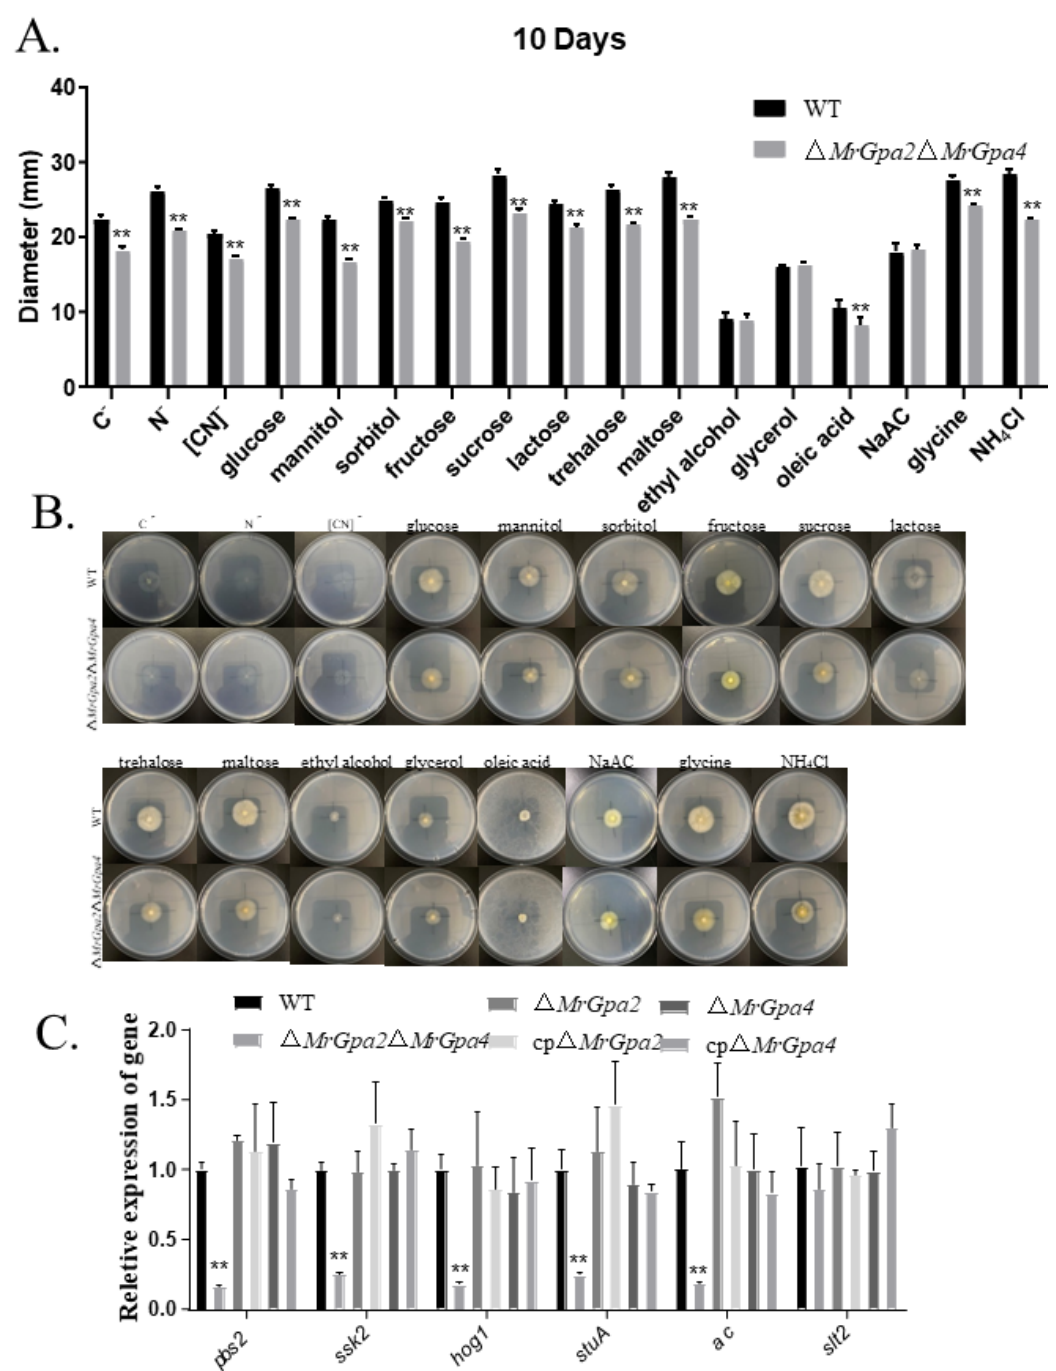
Figure 4. MrGpa2 and MrGpa4 affect hyphal growth in CZAs plates. ( A ) Colony diameters of WT and ∆ MrGpa2 ∆ MrGpa4 strains were estimated on the plates of CZA and modified CZAs and in the absence of carbon (C–), nitrogen (N–), or both ([CN]–). ( B ) Colony phenotype of WT and ∆ MrGpa2 ∆ MrGpa4 strains. ( C ) The expression of six growth-associated genes in WT and ∆ MrGpa2 ∆ MrGpa4 strains. ** p <